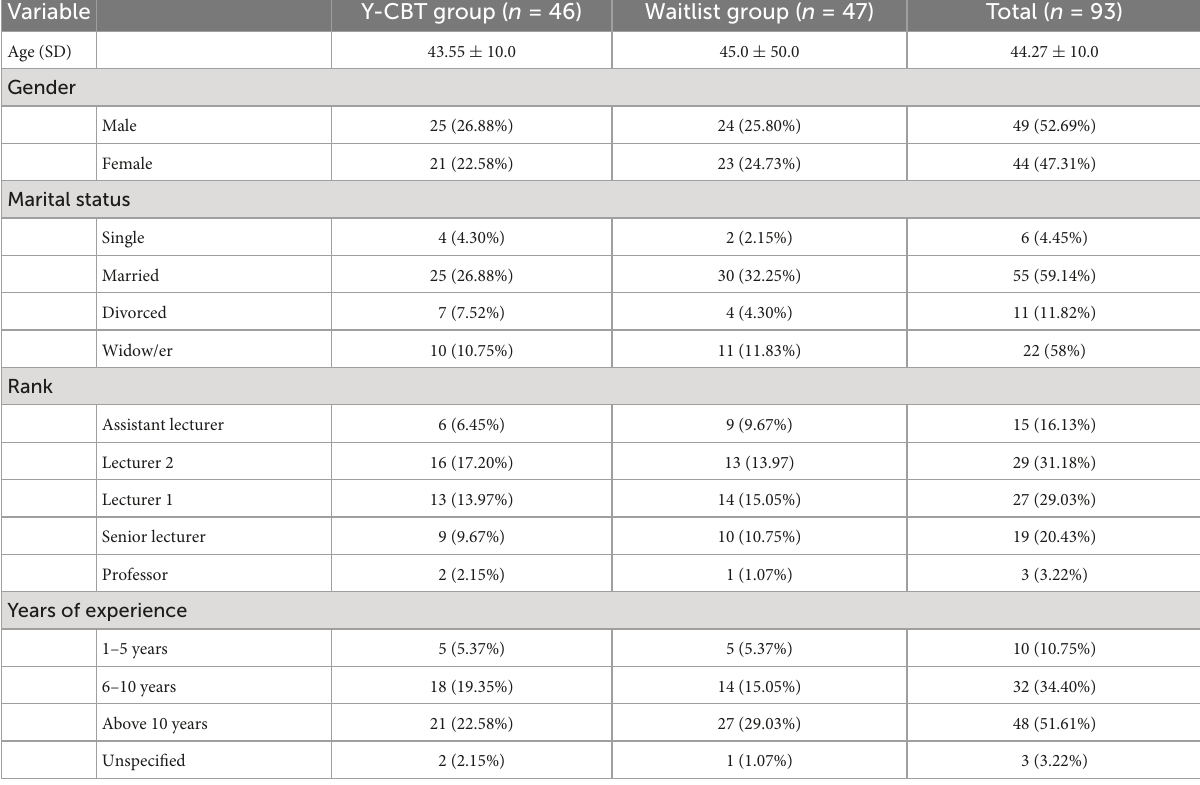
TABLE 1 Participants’ demographic